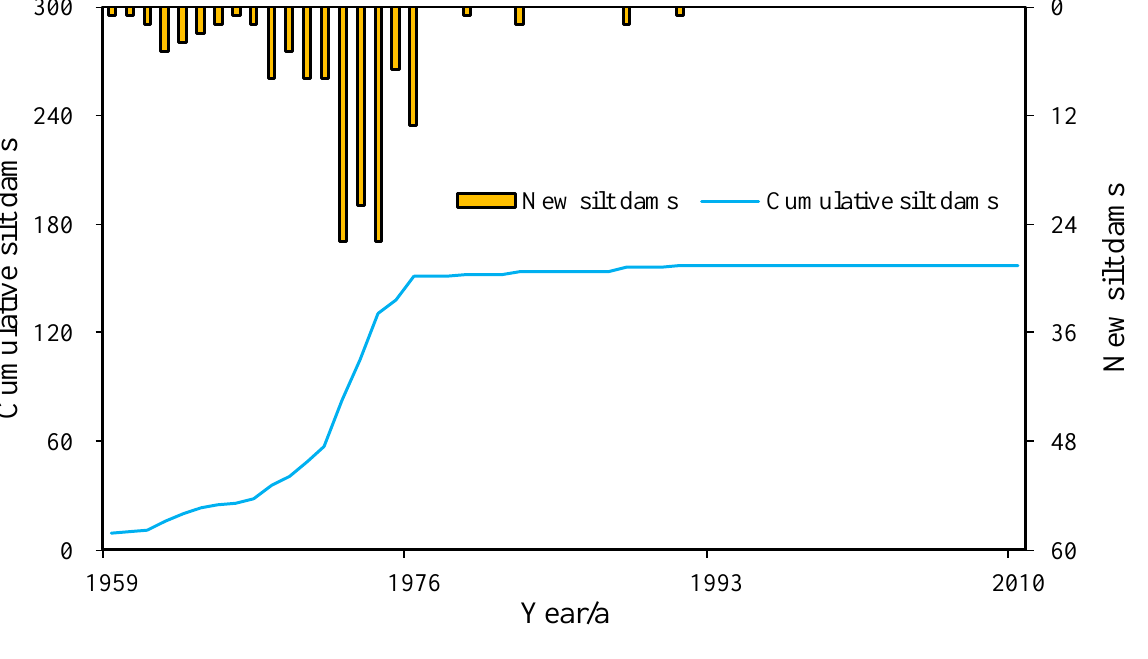
Figure 13. Changes in number of silt dams (storage capacity > (0.1)10 6 m 3 ) in the Chabagou River Watershed.